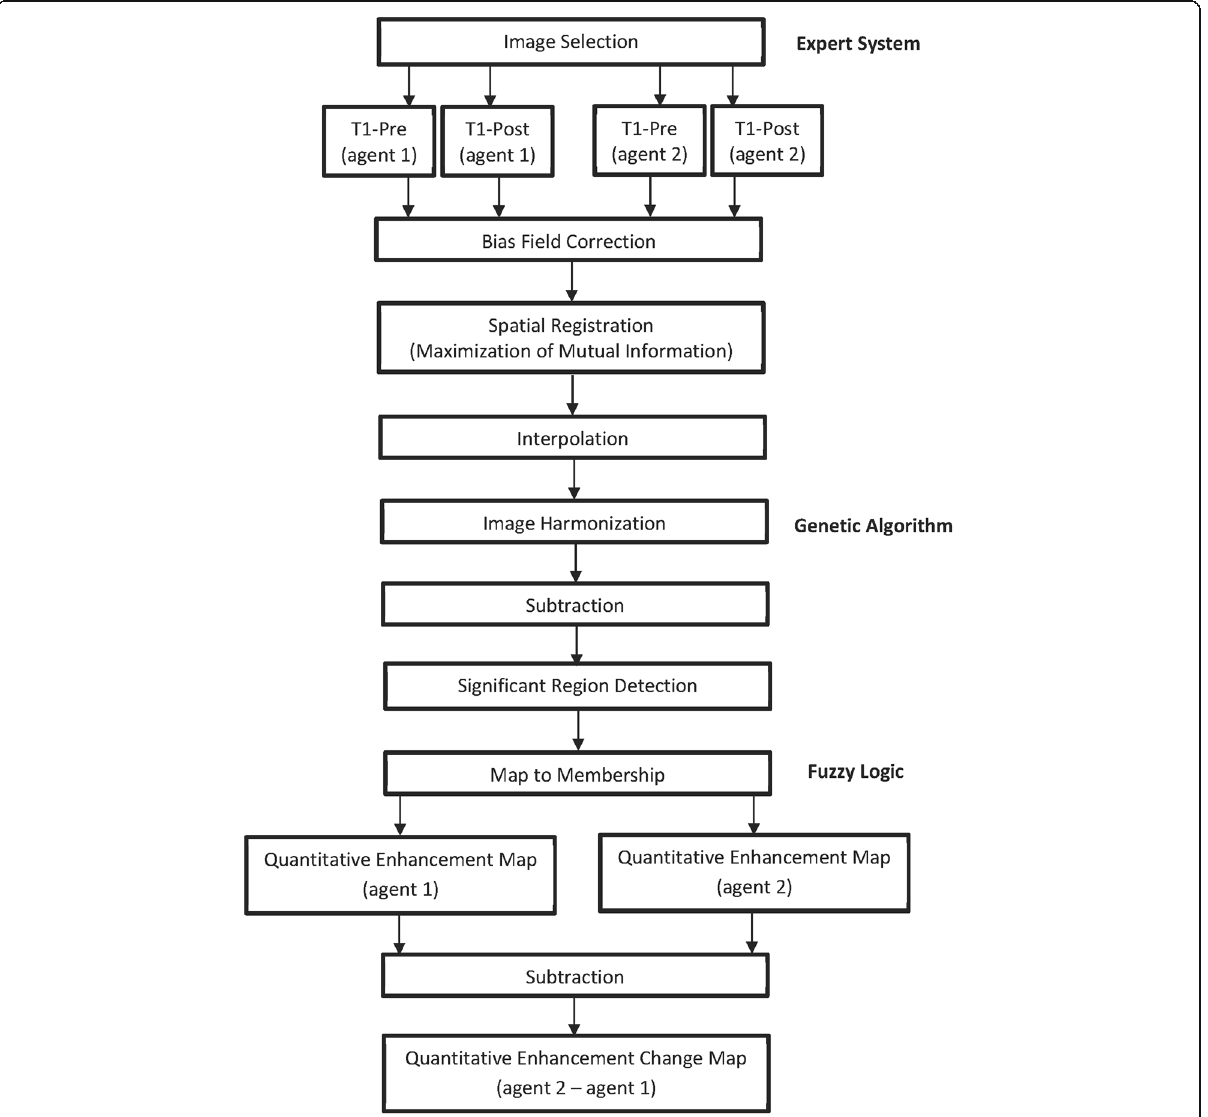
Fig. 1 The quantitative enhancement (QE) analysis pipeline for comparing two GBCAs. T1-weighted unenhanced/T1-weighted contrast-enhanced pairs are acquired for both contrast agents. Bias field correction using the N4 algorithm is performed on all images, after which images are registered using an “ all to one ” approach. Subsequently, machine learning based intensity harmonisation is performed “ all to one ” . QE maps are calculated for each GBCA, and the difference between the QE map for the two GBCAs is